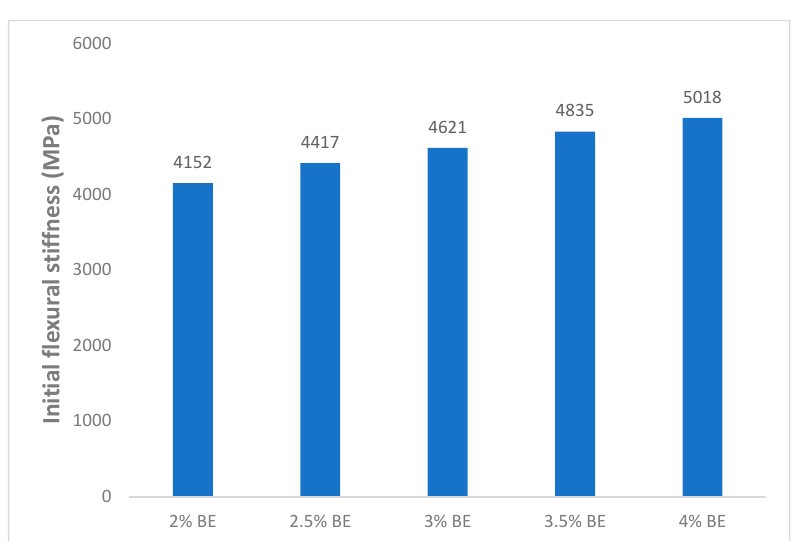
Figure 13. Results for the initial flexural stiffness of RAP. Table 6. Four-point bending test outcome at 20°C.